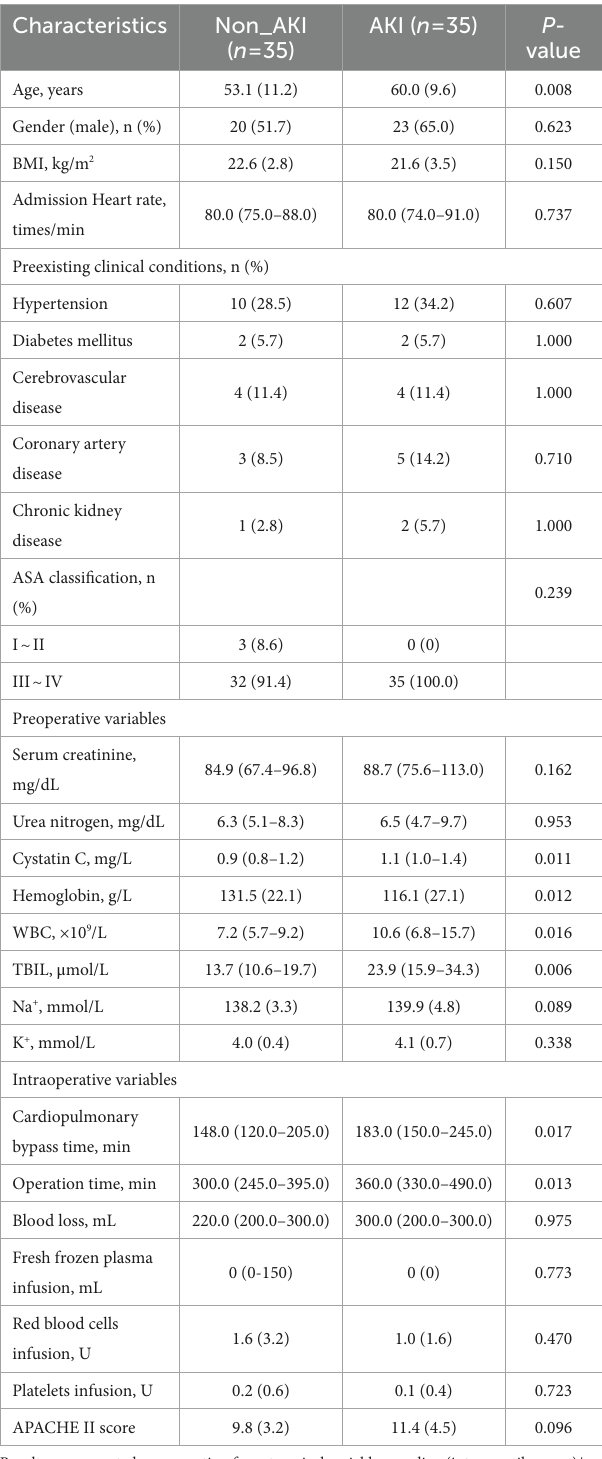
TABLE 1 Demographic and baseline characteristics of all patients.